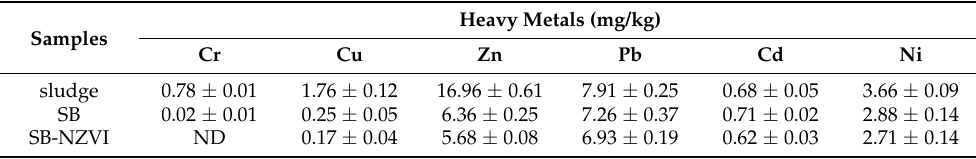
Table 1. Leaching concentration of heavy metals from municipal sludge, SB, and SB-NZVI.